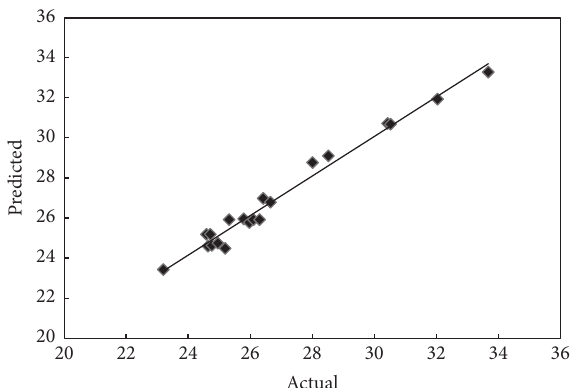
Figure 1: Predicted versus actual values for yield of OPEFB biochar.